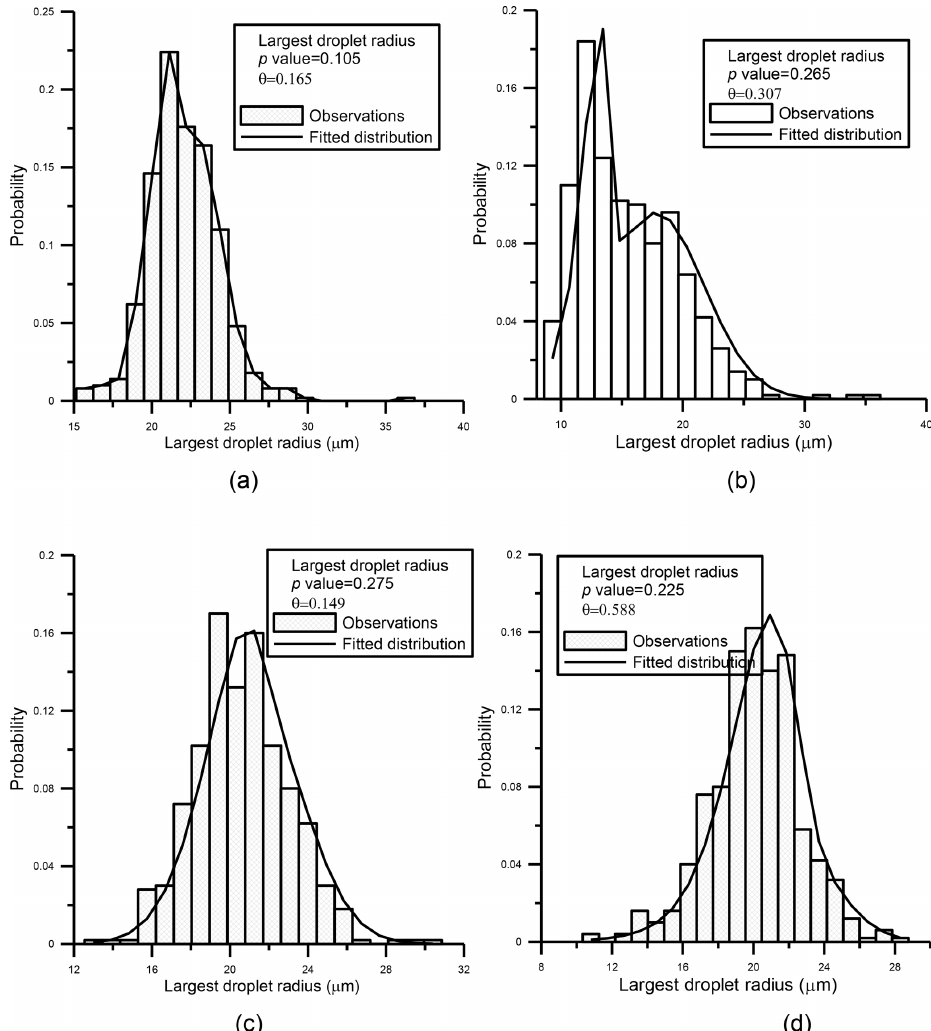
Figure 7. For four random samples that are distributed following the admixture distribution (with sample size 500), observed (histogram) and fitted (solid line) using Eq. (6). Also shown for each distribution are the p value of the goodness of fit test and the parameter θ indicating the weight of the Gumbel